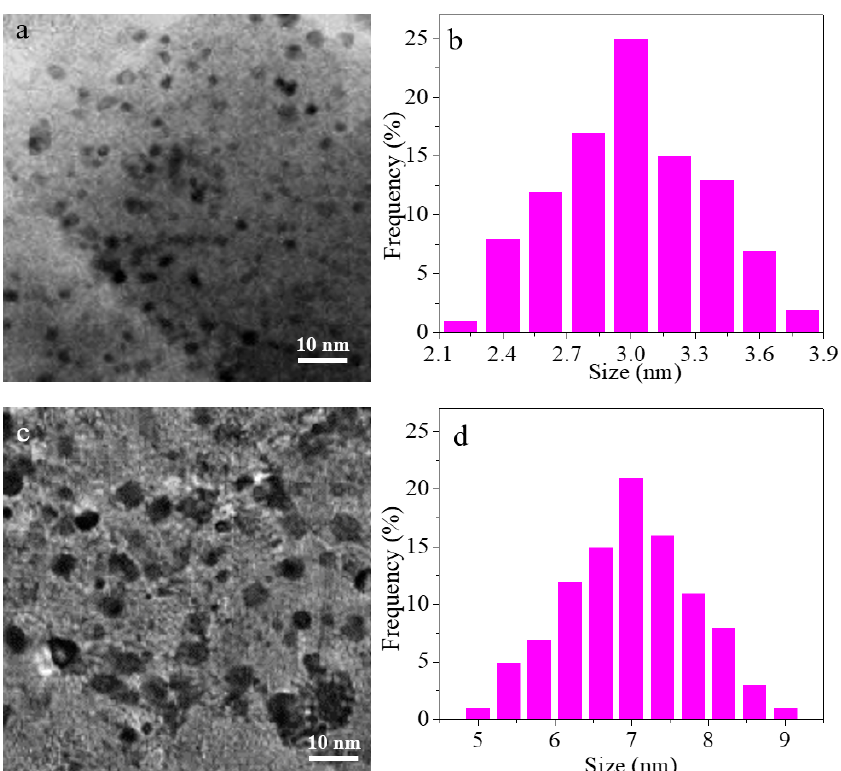
Figure 8. ( a ) TEM image of Rh/ γ -Al 2 O 3 catalysts (ALD) after running 15 h in DRM reaction; ( b ) Size distribution of Rh nanoparticles in Figure 8a; ( c ) TEM image of Rh/ γ -Al 2 O 3 catalysts (IWI) after running 15 h in DRM reaction; ( d ) Size distribution of Rh nanoparticles in Figure 8c.